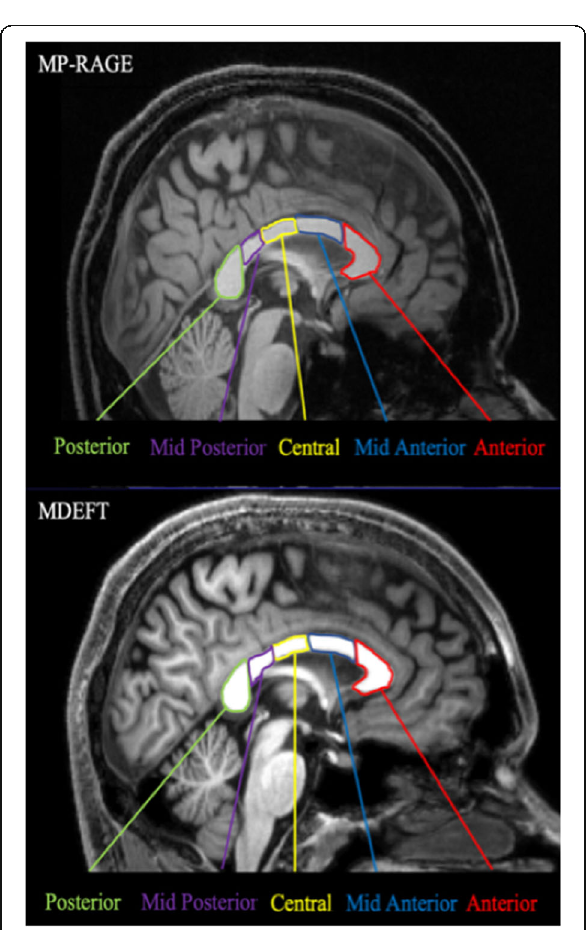
Fig. 2 The anatomical locations of CC including five main sub- regions: anterior, mid-anterior, central, mid-posterior, and posterior